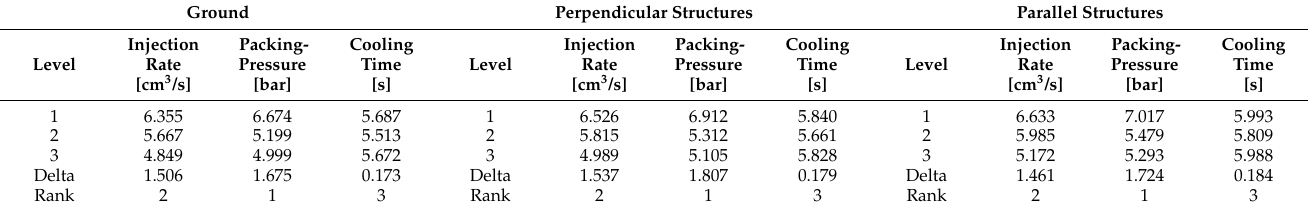
Table 7. Response table of means—impact bending tests with different surface-structured specimens. Ground Perpendicular Structures Parallel Structures